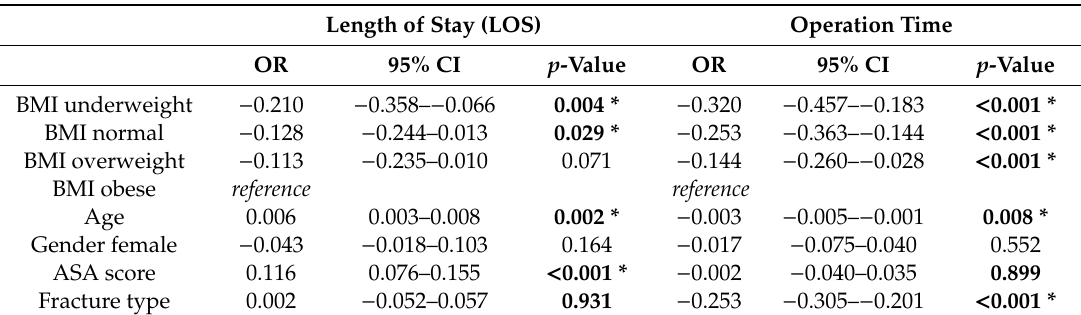
Table 5. Linear regression for length of stay (log.) and operation time (log.) over BMI categories adjusted for age, gender, ASA score, and fracture type.